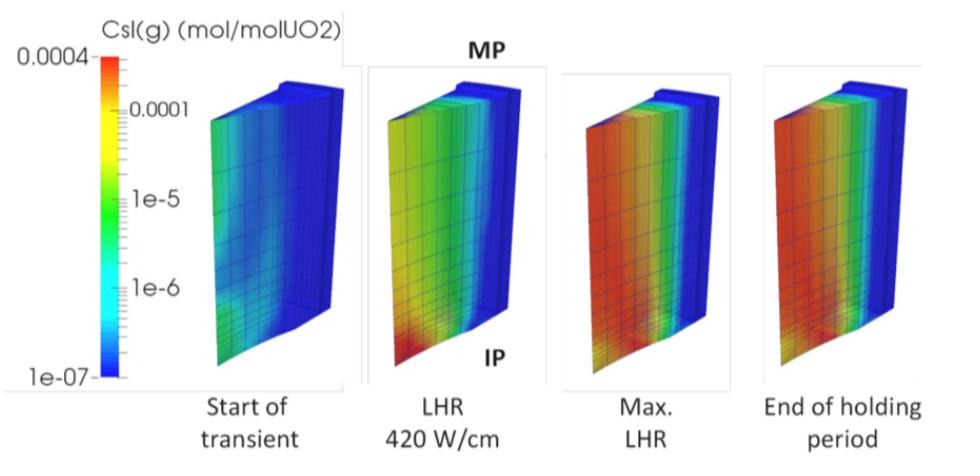
Figure 6. An example calculation with ALCYONE that predicts the concentration of CsI gas in urania fuel during a transient